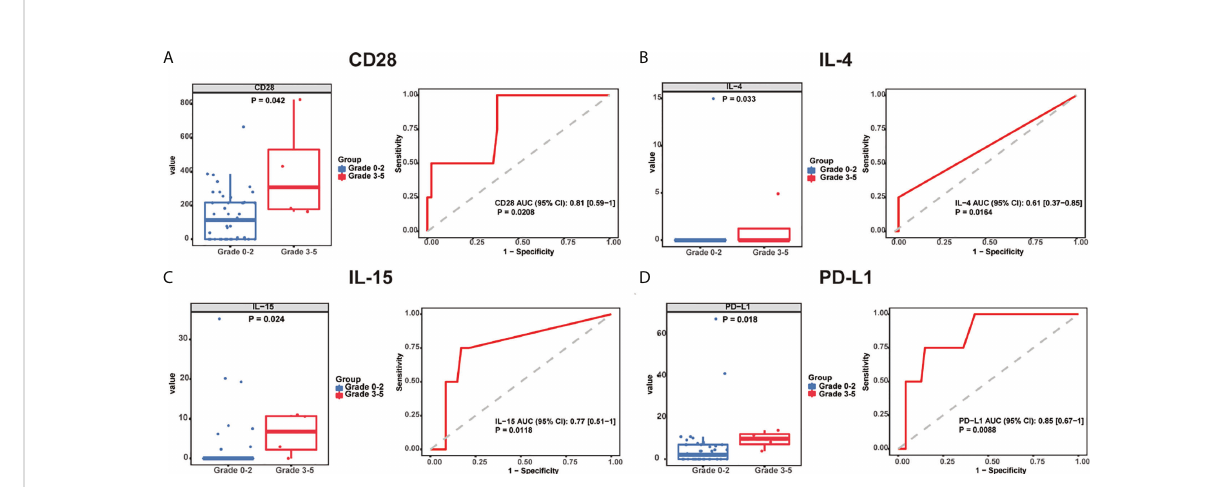
FIGURE 1 Baseline serum cytokine levels are signi fi cantly associated with irAE development and severity. Box plots (left) showing the distribution of serum cytokines (A) CD28, (B) IL-4, (C) IL-15, and (D) PD-L1 in grade 0-2 and 3-5 patients. ROC curve (right) analysis of sensitivity and speci fi city of serum cytokines (A) CD28, (B) IL-4, (C) IL-15, and (D) PD-L1 from baseline, to distinguish between grade 0-2 and 3-5 irAEs. The median of each group and P-value were calculated using the Mann-Whitney U test (P < 0.05). irAEs: immune-related adverse events, ROC: receiver operating